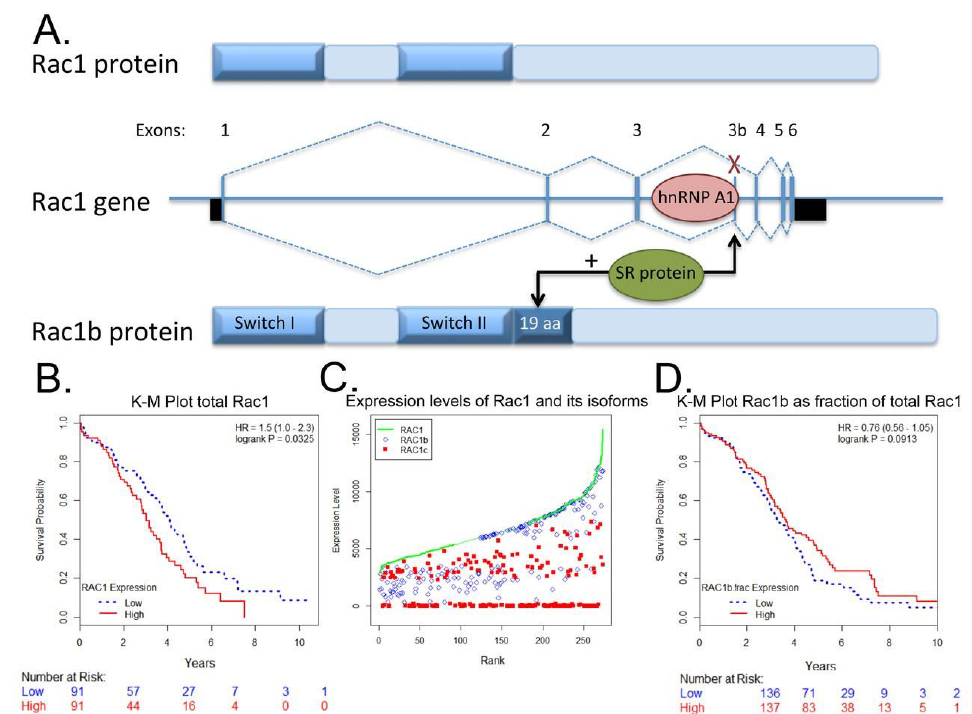
Figure 6. High total RAC1 expression predicts reduced ovarian cancer patient survival. ( A ) Rac1 undergoes regulated splicing in response to growth factor signaling, which is subject to positive and negative regulation by hnRNP A1 and SR protein. The resulting splice variant is called Rac1b and contains a 19 amino acid insert adjacent to the Switch II region. Rac1b is a fast cycling, constitutively active and frequently overexpressed in cancer, including ovarian cancer. ( B ) Kaplan-Meier plot of high vs. low total RAC1 mRNA expression. TCGA datasets for total and RAC1 isoform mRNA expression in ovarian cancer patients from ISOexpresso; uc003spx.3 (canonical RAC1) and uc003spw.3 (RAC1b containing exon 3b/4). Analyses were restricted to 298 patients with Stage III and Stage IV disease. Patients were divided into 3 groups based on total Rac1 expression. Upper tertile values represent high total Rac1 expression and lower tertile values represent low expression, middle values were excluded. Patients with high RAC1 expression have worse survival outcomes than those with low RAC1 expression (HR = 1.5, p = 0.0325); analogous results obtained using data direct from TCGA and CASViewer. No evidence for an association between isoform RAC1b and survival outcomes (HR = 0.96, p = 0.82, not shown). Higher expression of the canonical RAC1 isoform trended to lower survival probability, though was not statistically significant (HR = 1.37, p = 0.121). ( C ) Plot of total RAC1 (green line), canonical RAC1c (blue diamond), and RAC1b (red square) expression in each patient ranked according to expression levels. ( D ) Kaplan-Meier plot of RAC1b as a fraction of total RAC1, with two groups defined based on median expression. High RAC1b expression (HR = 0.76, p = 0.0913).